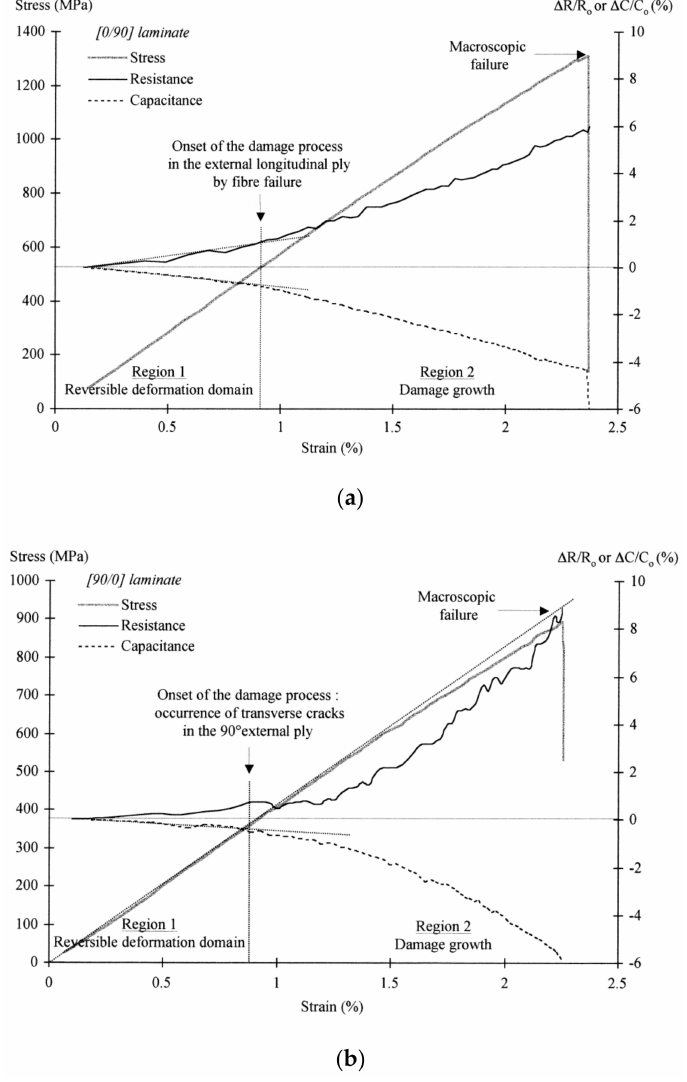
Figure 3. ( a ) Changes in stress and AC measurements as a function of the applied strain during a flexural monotonic loading for [0/90] composite, ( b ) Changes in stress and AC measurements as a function of the applied strain during a flexural monotonic loading for [90/0] composite